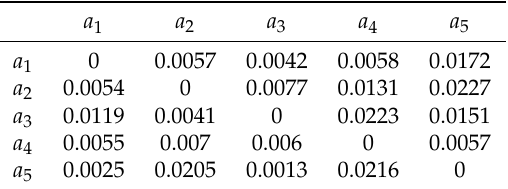
Table 12. Comprehensive dominance degrees between hotels in Method 2.